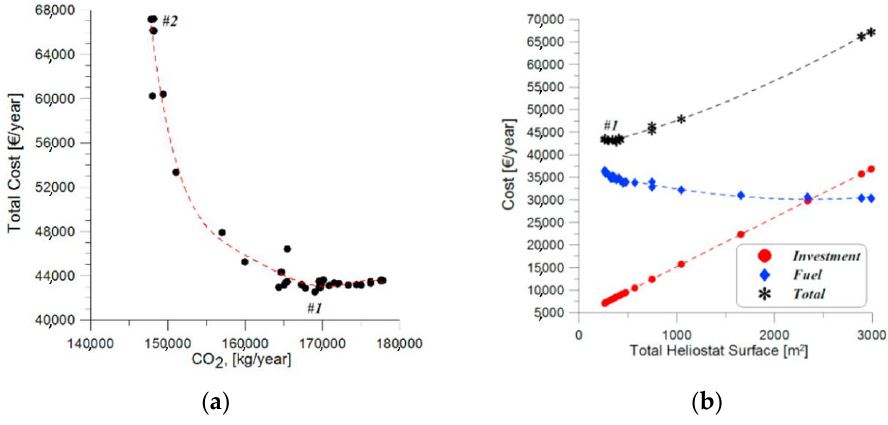
Figure 14. ( a ) Total cost vs CO 2 emissions ( b ) Total yearly costs [112]. For evaluation of the thermo-economic indicators, i.e., utilization factor, primary energy saving, simple payback, two extreme cases (#1 and #2 in Figure 13) were selected and compared with the “base case” without the solar tower.